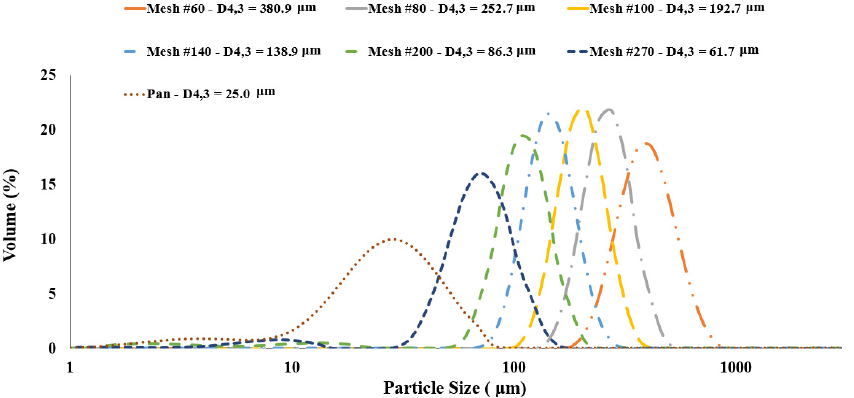
Figure 3. Partticle size distributions of yellow pea sieved fractions.